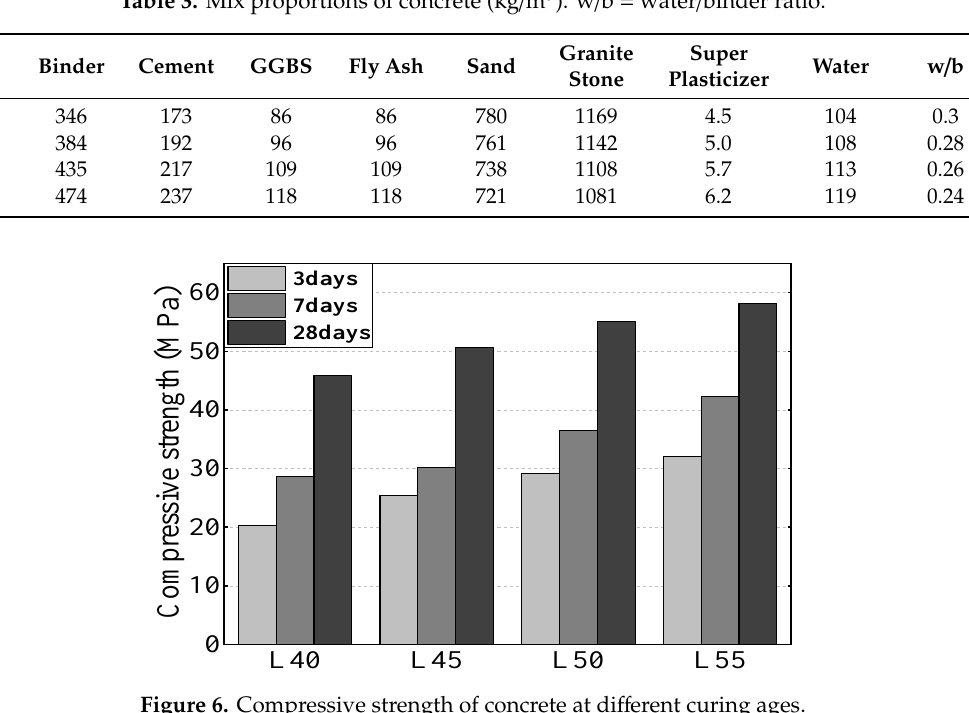
Table 3. Mix proportions of concrete (kg/m 3 ). w/b = water/binder ratio.